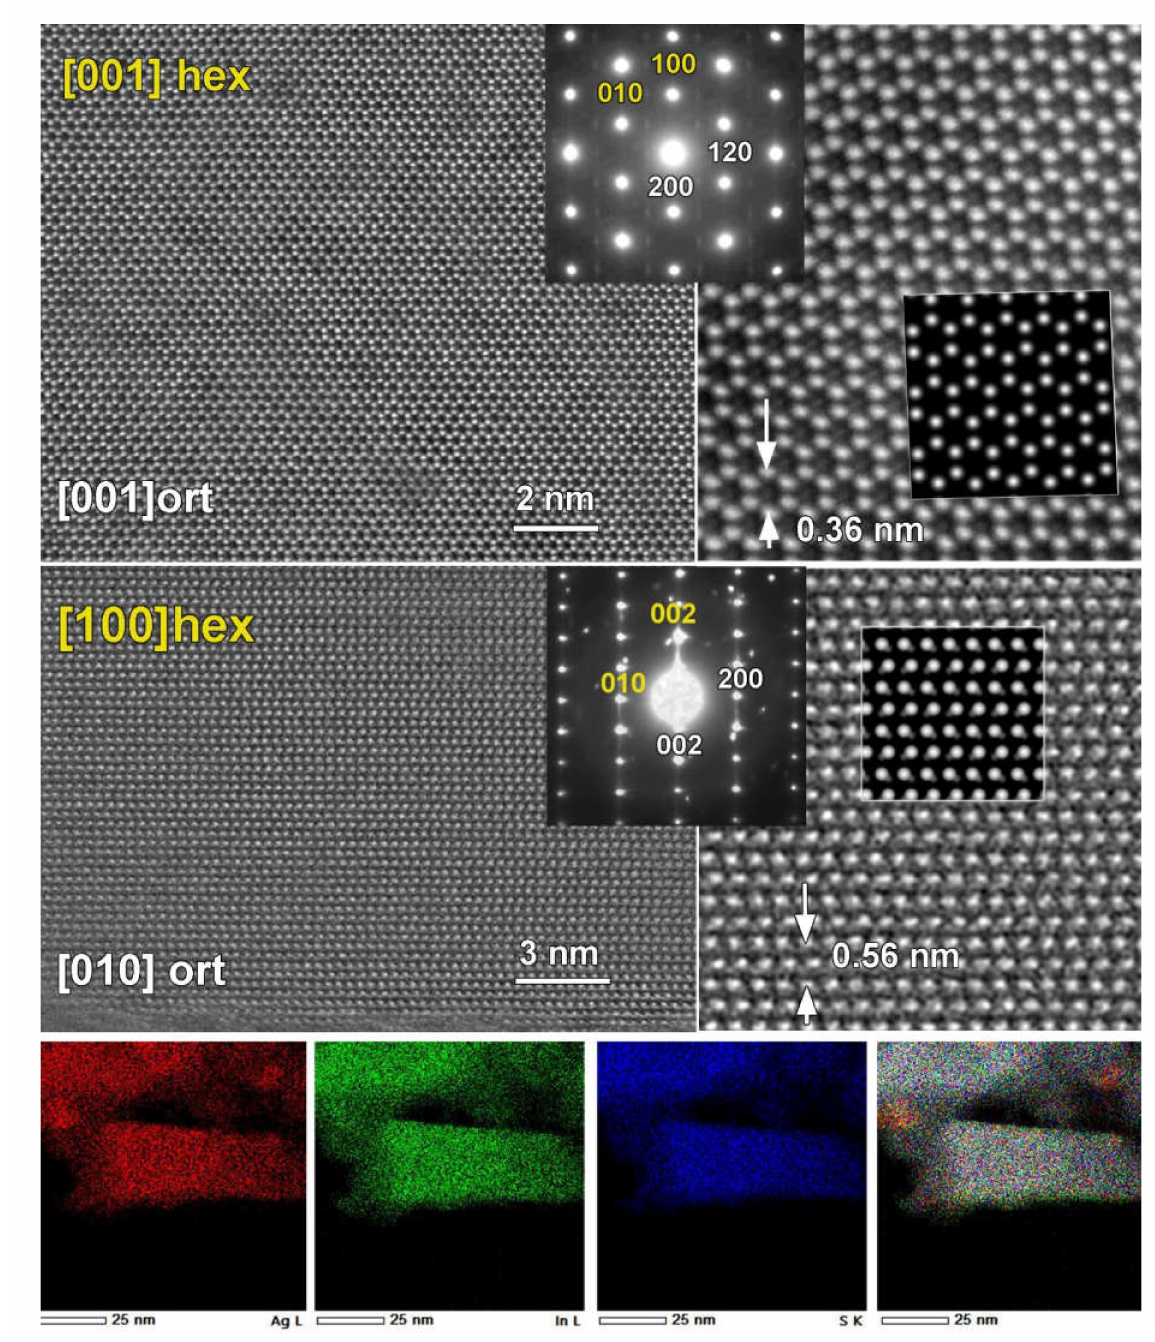
Figure 7. ( Top and Middle, Left ) High-resolution HAADF–STEM images and corresponding electron diffraction (ED) patterns of the two main zones of the (pseudo)-wurtzite AgInS 2 structure: top panel, [001] and middle panel, [010] ort /[100] hex . High-intensity diffraction spots can be indexed using hexagonal wurtzite structure ( P 6 3 mc , yellow). All of the diffraction spots, including those with lower intensity can be indexed using the orthorhombic wurtzite-like structure ( Pna 2 1 space group). Top and Middle, Right : Magnified high-resolution HAADF–STEM images of the two